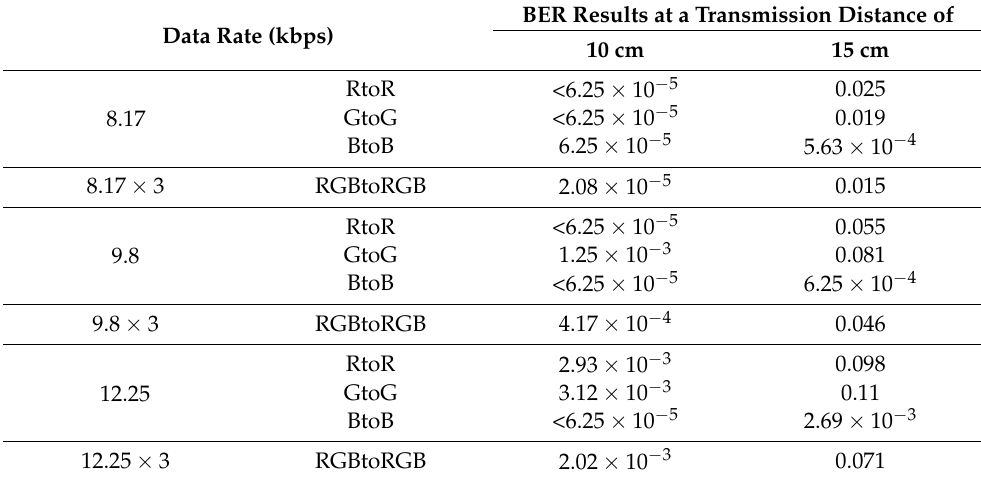
Table 2. BER comparison of the 3 × 3 MIMO LED-to-LED system at a transmission distance of 10 and 15